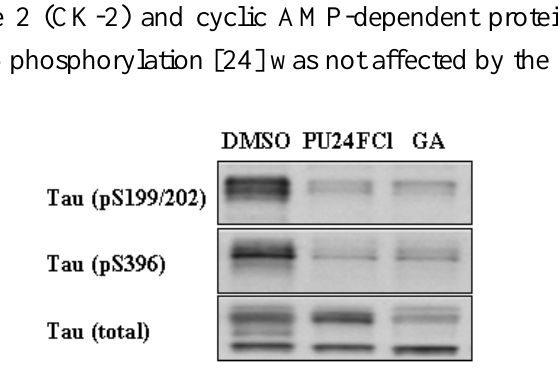
Figure 1. Effects of Hsp90 inhibition on tau phosphorylation. COS-7 cells were transiently transfected to over-express human tau protein longest isoform. At 12 h after transfection, cells were incubated for 20h with10 m M PU24FCl or 400nM GA, cells were collected and lysed, the resulting lysates analyzed by